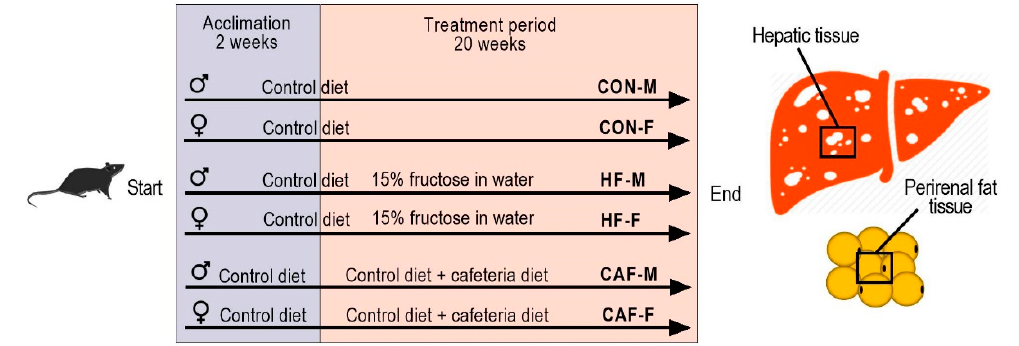
Figure 1. Experimental groups and treatments. CON, control diet; HF, high-fructose diet; CAF, M, males; F, cafeteria diet; M, males; F, females.